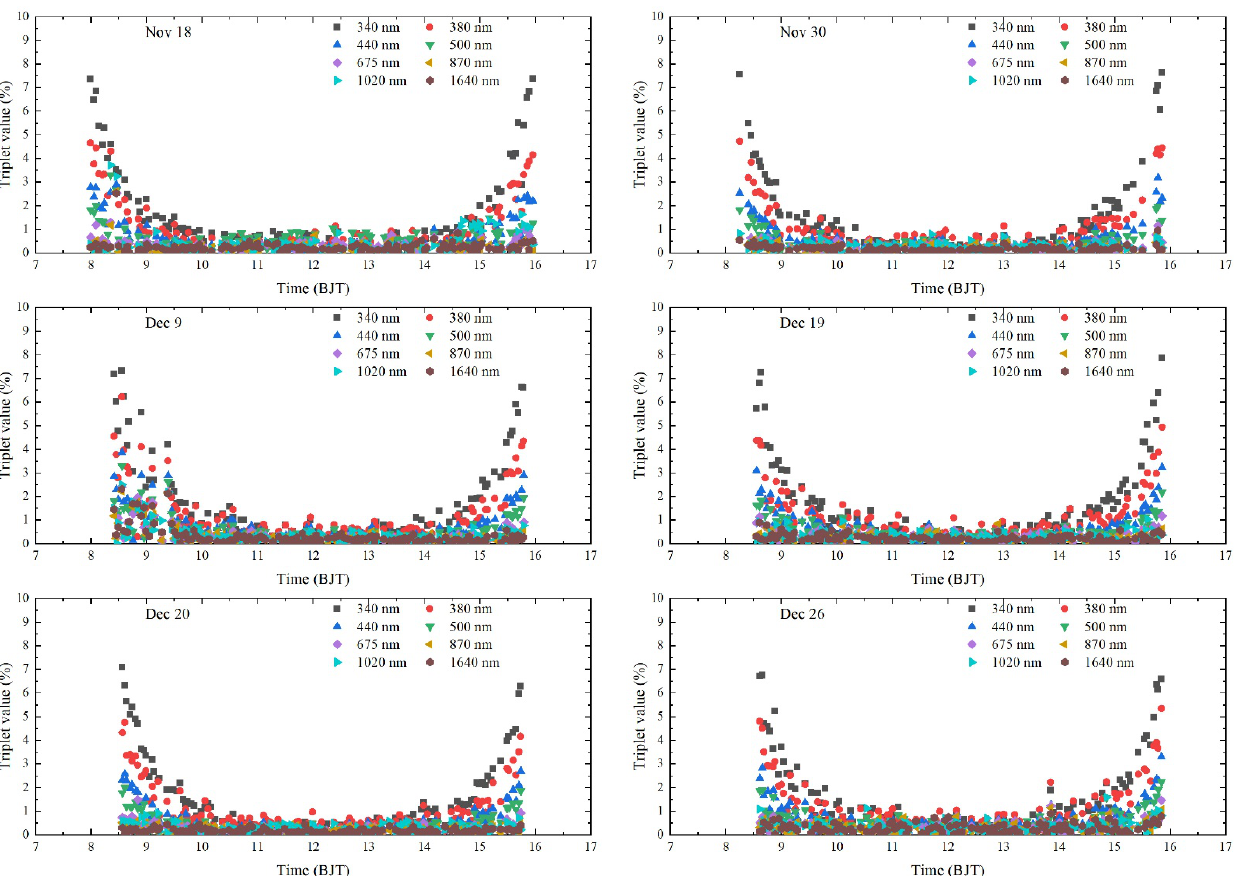
Figure 4. Diurnal triplet ratios at each wavelength on the six study days.